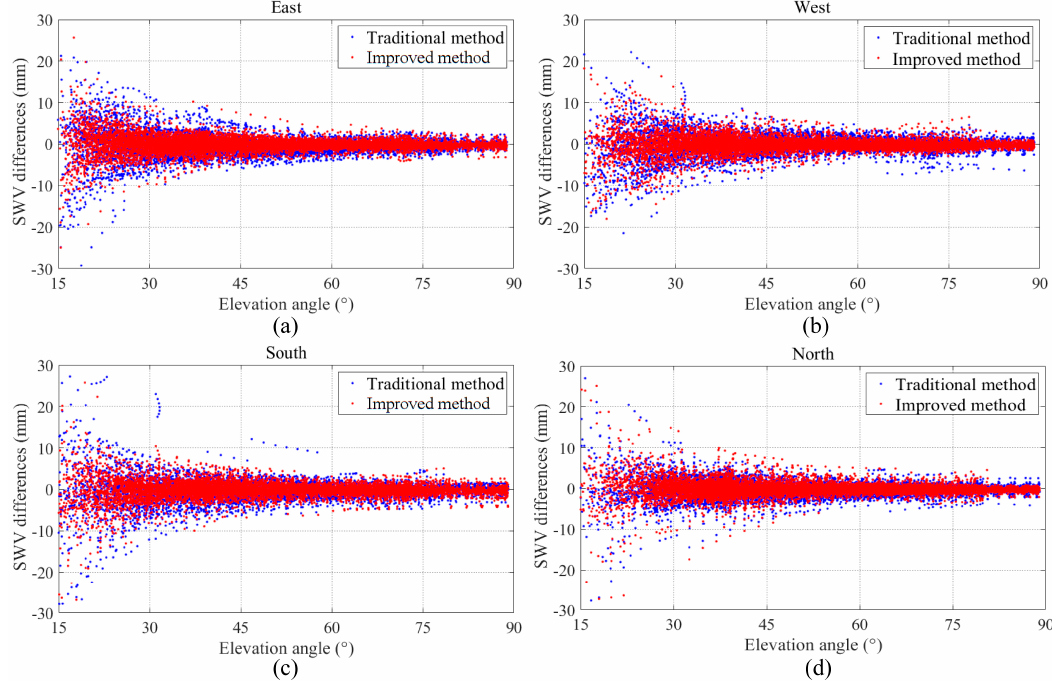
Figure 12. Comparison of the SWV differences between the observed SWV and retrieved SWV from the three-dimensional tomographic water vapor field with the two methods in the four schemes. (a) Scheme East; (b) Scheme West; (c) Scheme South; and (d) Scheme North.